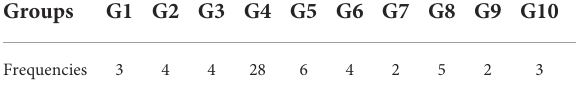
TABLE 2 Frequencies of the different groups identified in the functioning of the floodplains. Groups